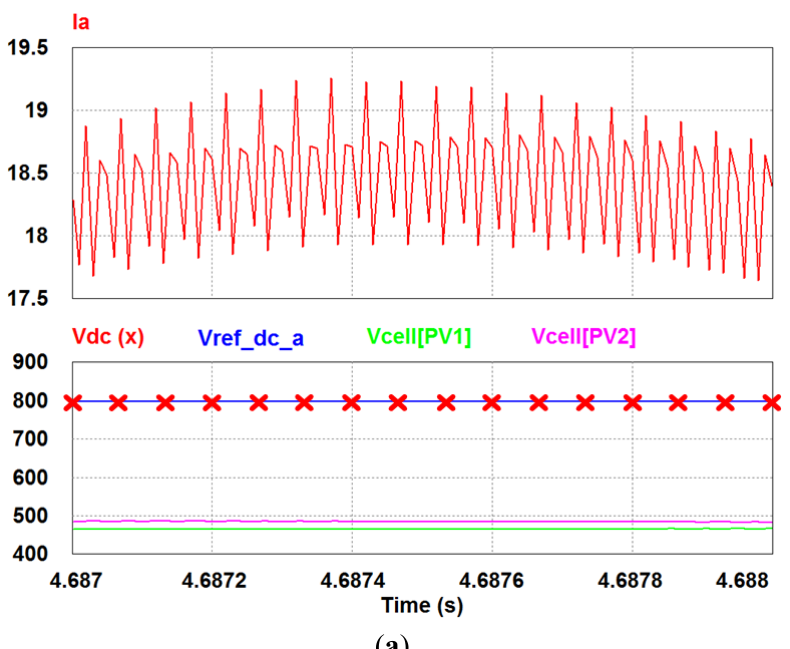
Figure 16. Simulation results for the a-phase current, the DC-link voltage, V PV cells voltages according to the DC-link reference voltage 800 V ( a ) and 600 V ( b